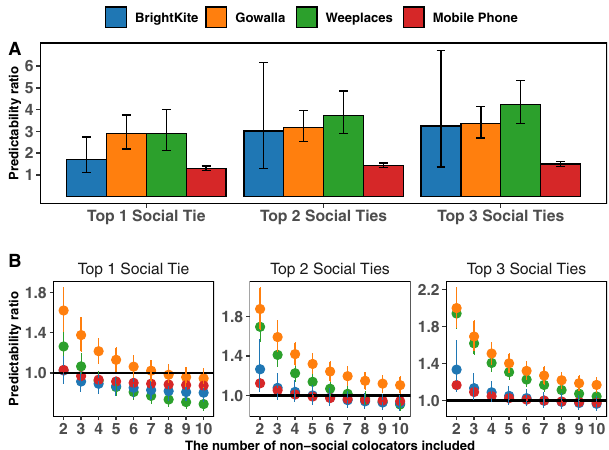
Fig. 3 Quantifying the predictive information aggregated from non-social colocator(s) with respect to social ties. A The predictability ratio Π ego ∣ social Π ego ∣ non-social colocator(s) between the top non-social colocator and (left- tie(s) / to-right) the top, top-2, and top-3 social tie(s). B The predictability ratios between the top 2 and 10 non-social colocators and the top, top-2, and top- 3 social tie(s). Error bars denote 95%